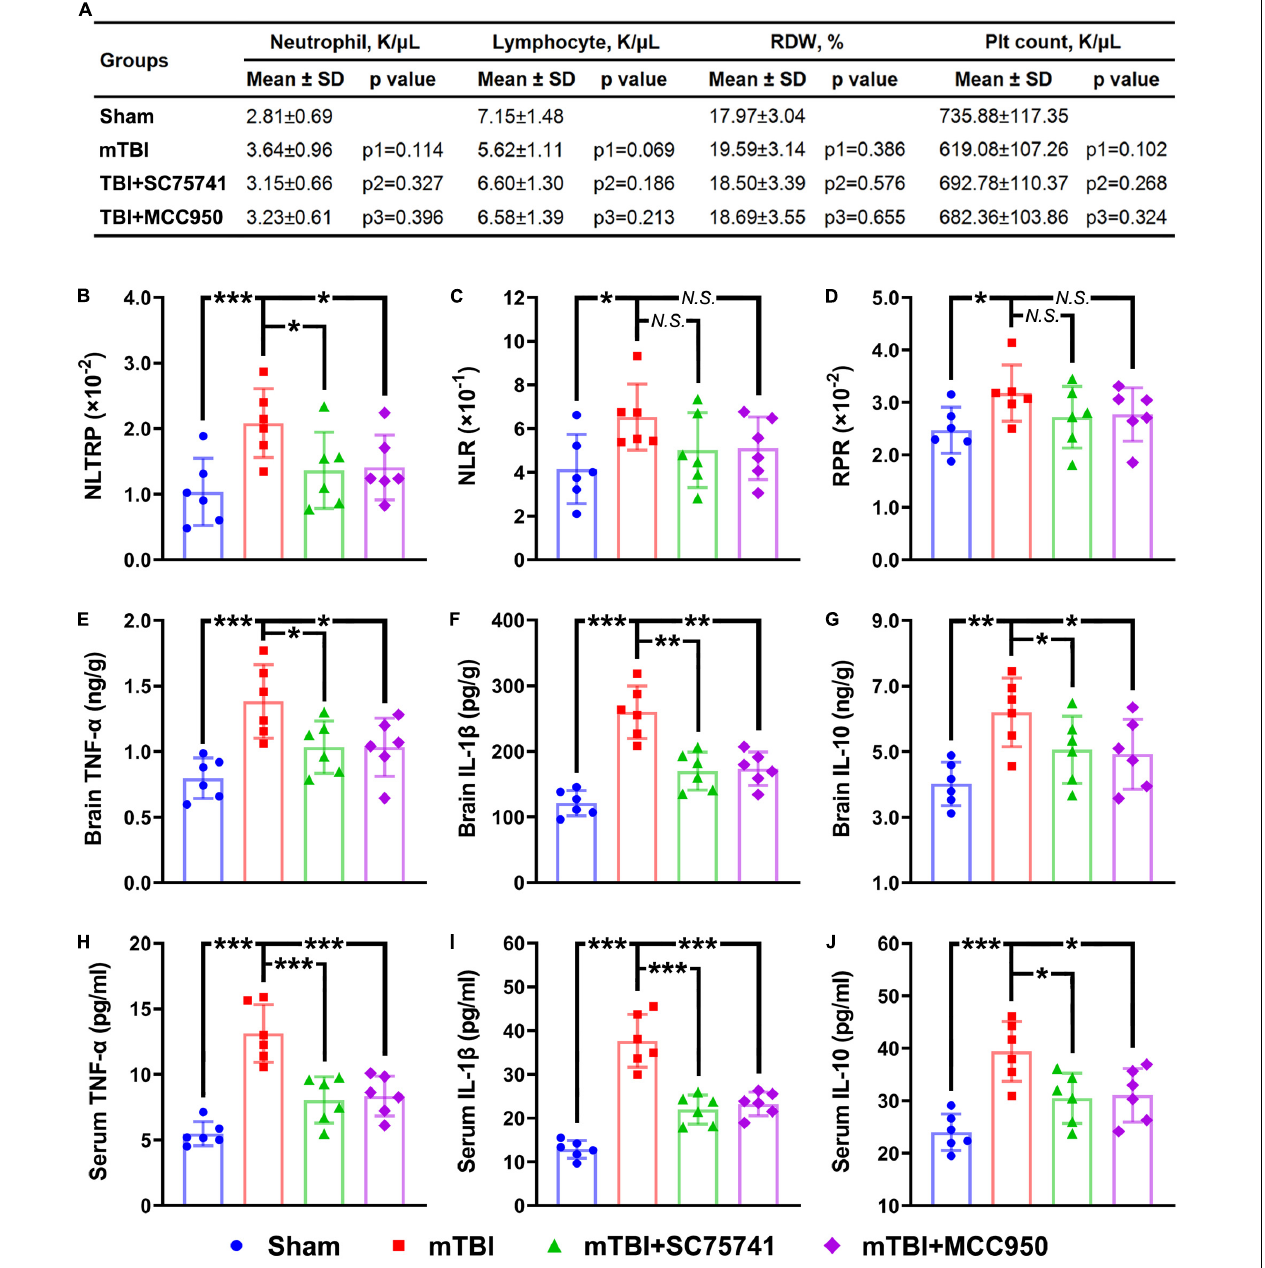
FIGURE 3 | NLTRP changes after mTBI and anti-inflammatory treatments in the mice model. (A) Blood neutrophil count, lymphocyte count, RDW, and platelet count of the mTBI mice. (B–D) NLTRP, NLR, and RPR levels of the mTBI mice. (E–G) The expression levels of inflammatory mediators TNF- α , IL-1 β , and IL-10 in the mice brain. (H–J) Blood TNF- α , IL-1 β , and IL-10 levels of the mTBI mice (n = 6/group). Data are presented as mean ± SD. p1, control vs. mTBI group; p2, mTBI vs. mTBI + SC75741 group; p3, mTBI vs. mTBI + MCC950 group. *** p < 0.001, ** p < 0.01, * p < 0.05. mTBI, mild traumatic brain injury; NLR, neutrophil-to-lymphocyte ratio; NS, no significance; RDW, red cell distribution width; RPR, red cell distribution width-to-platelet ratio; NLTRP, neutrophil-to-lymphocyte ratio times red cell distribution width-to-platelet